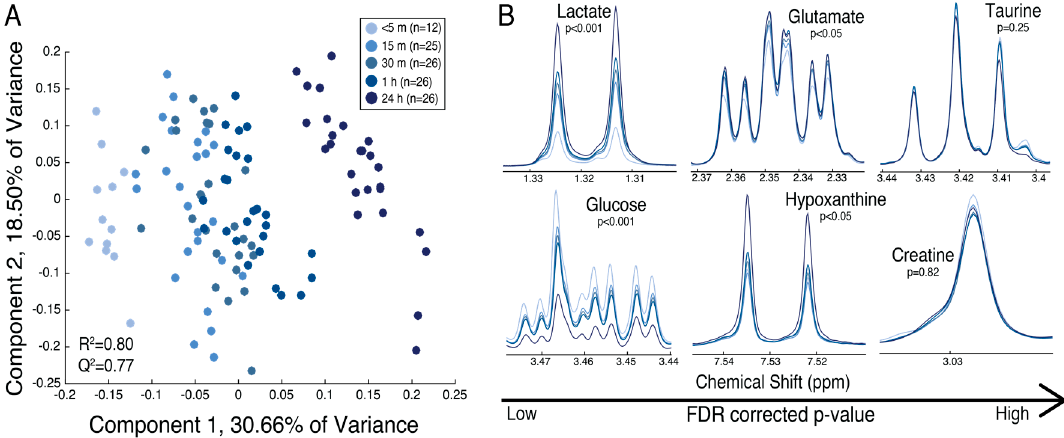
Figure 3. ( A ) The partial least squares discriminant analysis (PLS-DA) scores plot reveals separation of the specimens from the maternal surface of 13 placentas at five time points postdelivery: (1) <5 min ( n = 12), (2) 15 min ( n = 25), (3) 30 min ( n = 26), (4) 1 h ( n = 26), and (5) 24 h ( n = 26). The time points are represented as varying shades of blue, from light (<5 min) to dark (24 h); (B) mean spectra of time points displaying metabolites with varying significance of FDR-corrected p-values from left to right (low to high). Lactate significantly increased over time ( p < 0.001), while glucose diminished ( p < 0.001). Glutamate and hypoxanthine significantly increased over time ( p < 0.05), while taurine and creatine did not differ over 24 h. Table 2 displays means with standard errors, FDR-corrected p-value, and fold change between <5 min and 1 h following delivery for all metabolites